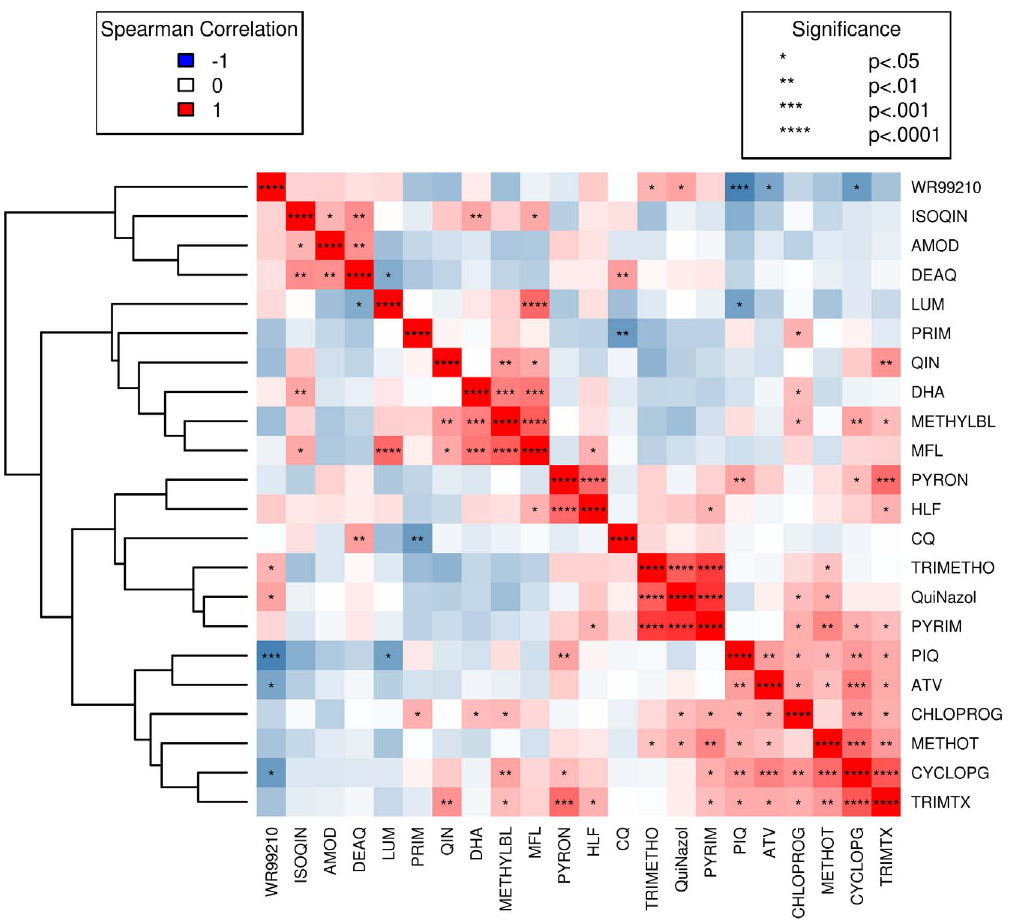
Figure 3. Cluster plot of drug correlations. Red to blue indicates the degree of positive to negative correlation. Significance levels of spearman rank tests are indicated with stars in each box (see legend).